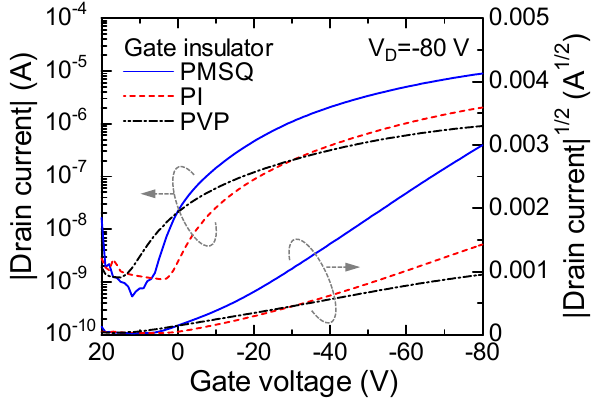
Figure 8. Densities of interface states ( D it ) above the valence band edge ( E v ) in the P3HT MIS capacitors consisting of the different gate insulators, as determined by impedance spectroscopy.